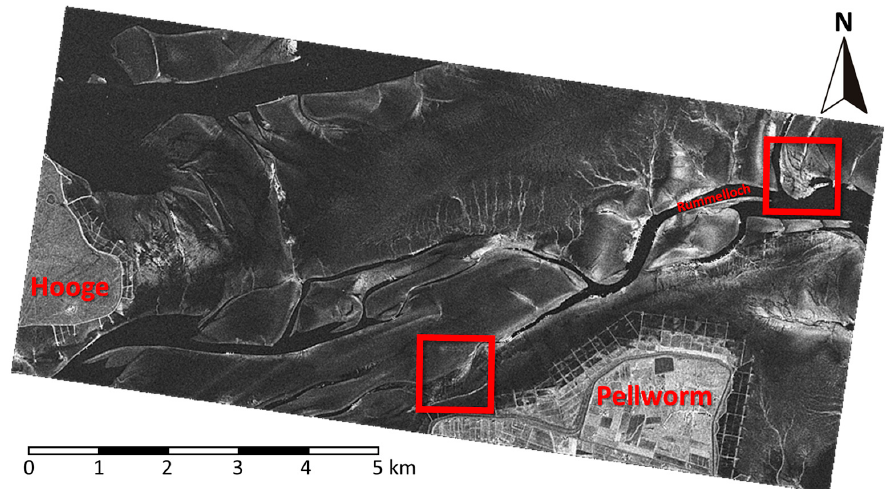
Figure 3. TerraSAR-X image of the area of interest, north of Pellworm and east of Hooge, acquired on 12 December 2012. The red squares denote two areas that were observed in greater detail. © DLR 2012. The locations of all (known) cultural traces are depicted in Figure 4, where the light-green background color marks the islands of Pellworm (bottom) and Hooge (left) and the yellow background color the former island of Strand (Figure 1). Several of those traces are meanwhile lost, particularly around the small island (so-called Hallig) of Südfall, because of the strong erosion by the tidal currents, wind, and waves. The red rectangle, again, marks the location of the SAR image shown in Figure 3. Four dark blue arrows mark those locations, where the dikes broke during the second “ Grote Mandrenke ” in 1634.